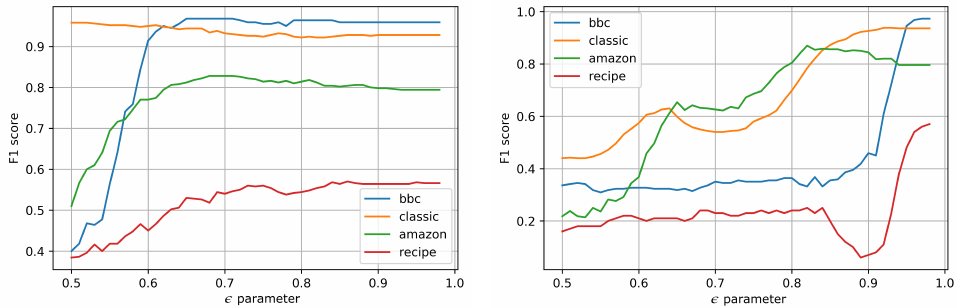
Figure 2. Representation of GTSM method’s (cid:101) parameter behaviour: ( left ) for word2vec; ( right ) for co-ocurrence matrix.